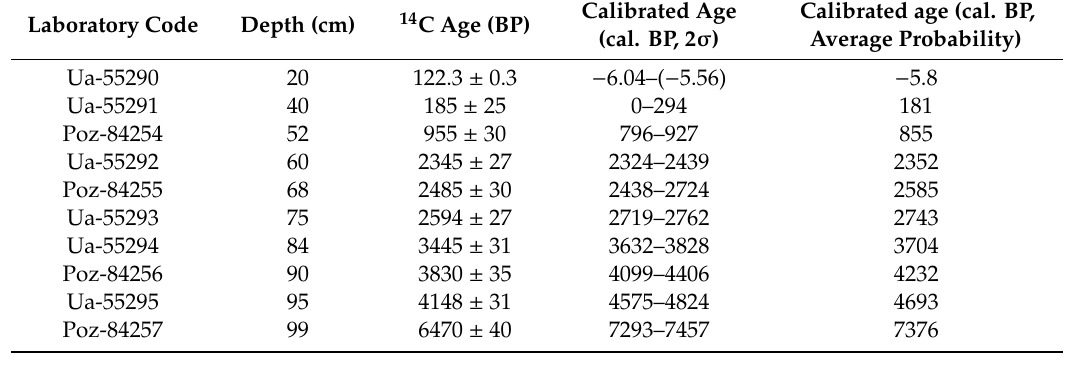
Table 2. AMS radiocarbon data with 2 σ range of calibrated ages from El Perro mire.